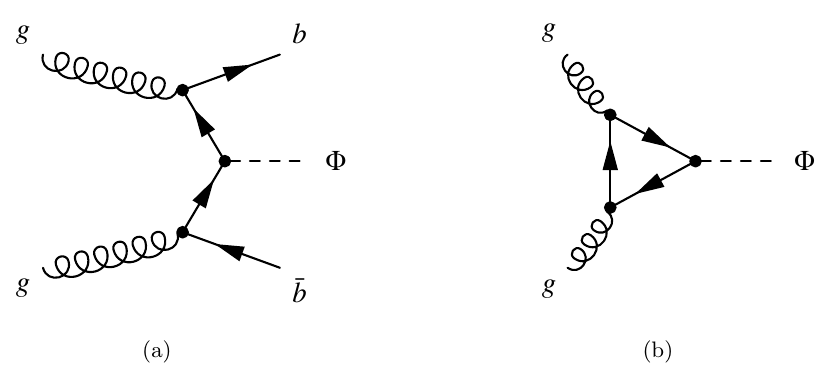
Figure 1 . Feynman diagrams for (a) the b -quark associated production mode and (b) the gluon- gluon fusion production